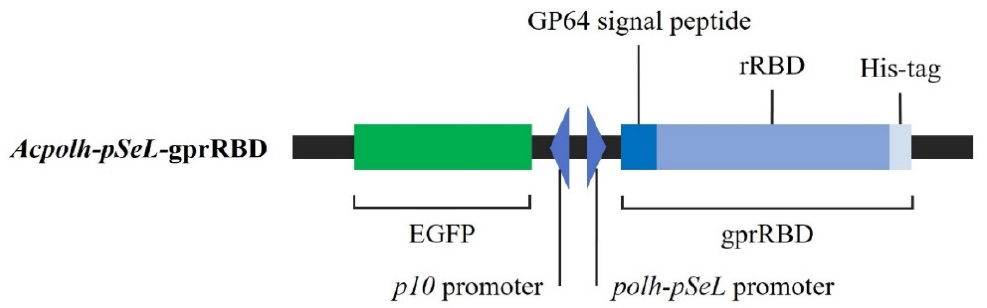
Figure 1. Recombinant baculovirus ( Acpolh-pSeL -gprRBD) for the expression of rRBD under the polh-pSeL promoter. GP64: viral secretion signal GP64; His-tag: six histidine tag. rRBD: SARS-CoV-2 receptor binding domain sequence (Wuhan-Hu-1 isolate) optimized for insects.